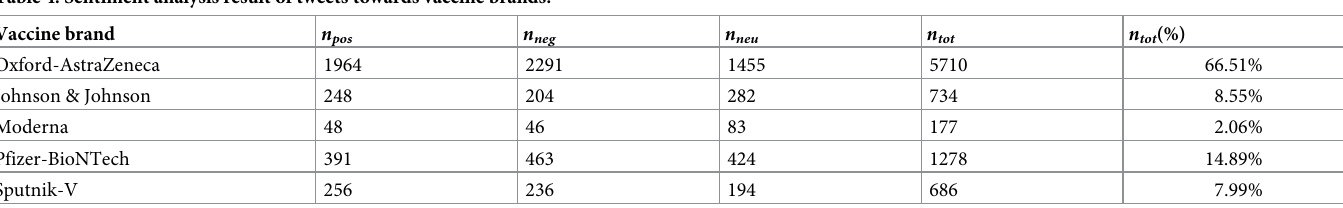
Table 4. Sentiment analysis result of tweets towards vaccine brands.